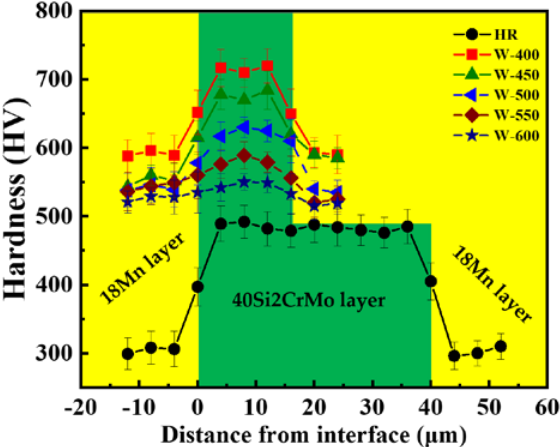
Figure 6. Hardness distribution of adjacent layers in composite steel.